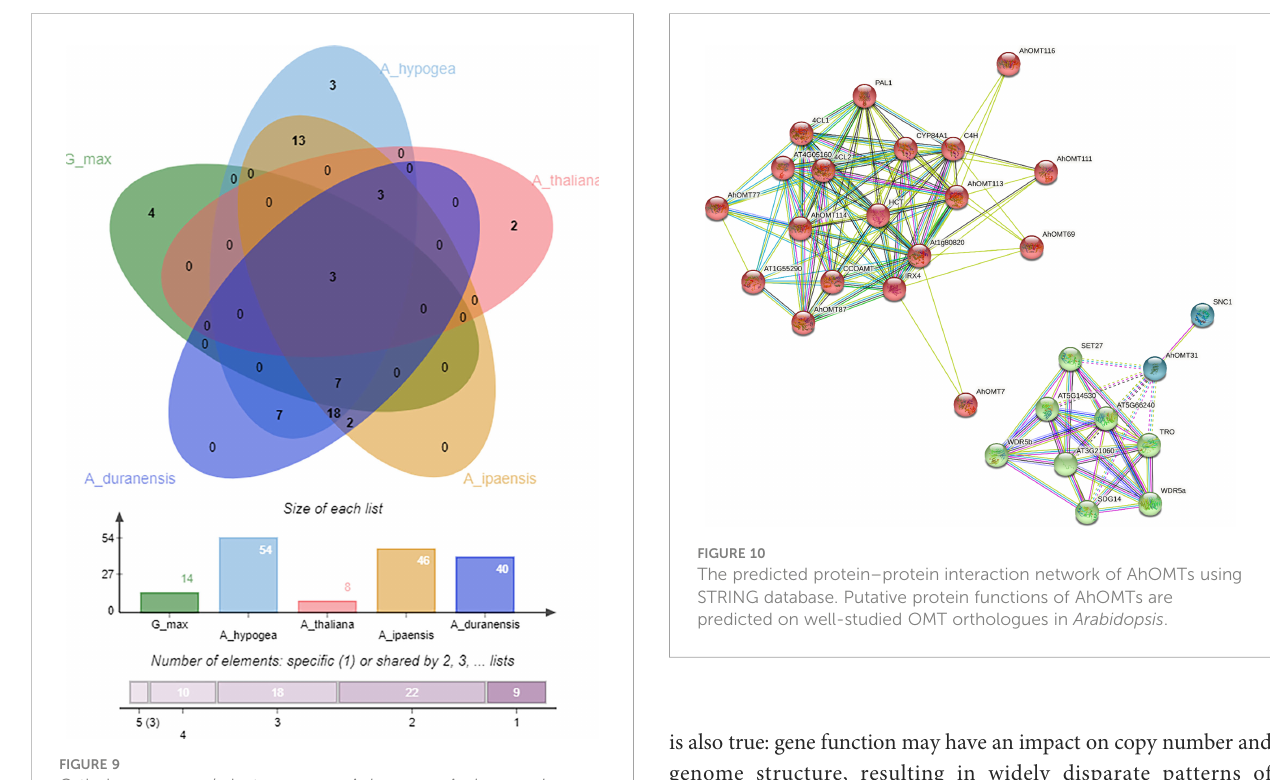
FIGURE 9 Orthologous genes ’ clusters among A. hypogea , A. duranensis , A. ipaensis , A. thaliana , and G. max . A. hypogea recorded maximum clustered. Eighteen gene clusters are solely composed of OMTs found in peanut diploid and tetraploid species, indicating that polyploidization has evolved new peanut-speci fi c orthologous OMT gene clusters.